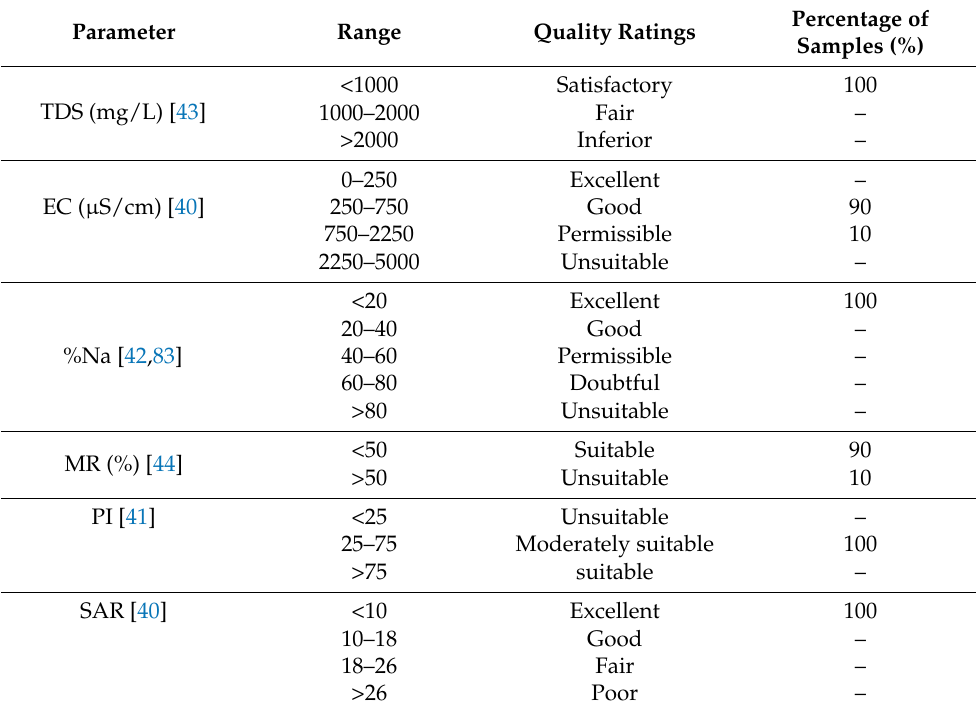
Table 8. Indices for determining the suitability of the groundwater for